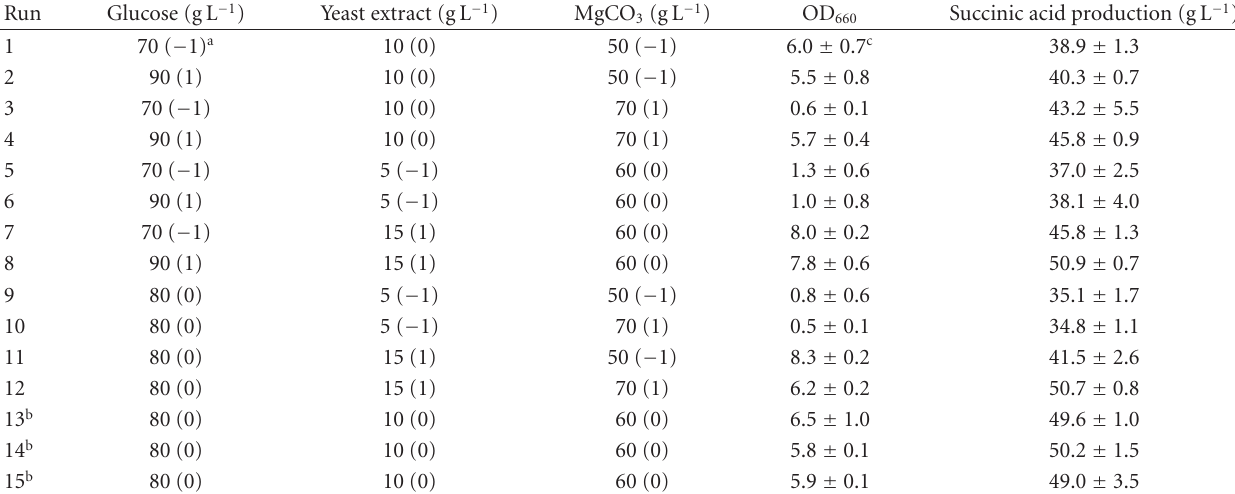
Table 3: The Box-Behnken design of RSM for the optimization of succinic acid production by A. succinogenes ATCC